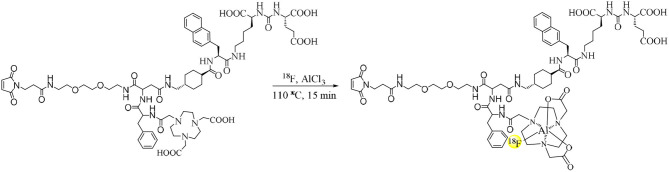
Radiosynthesis of Al18F-PSMA-CM.